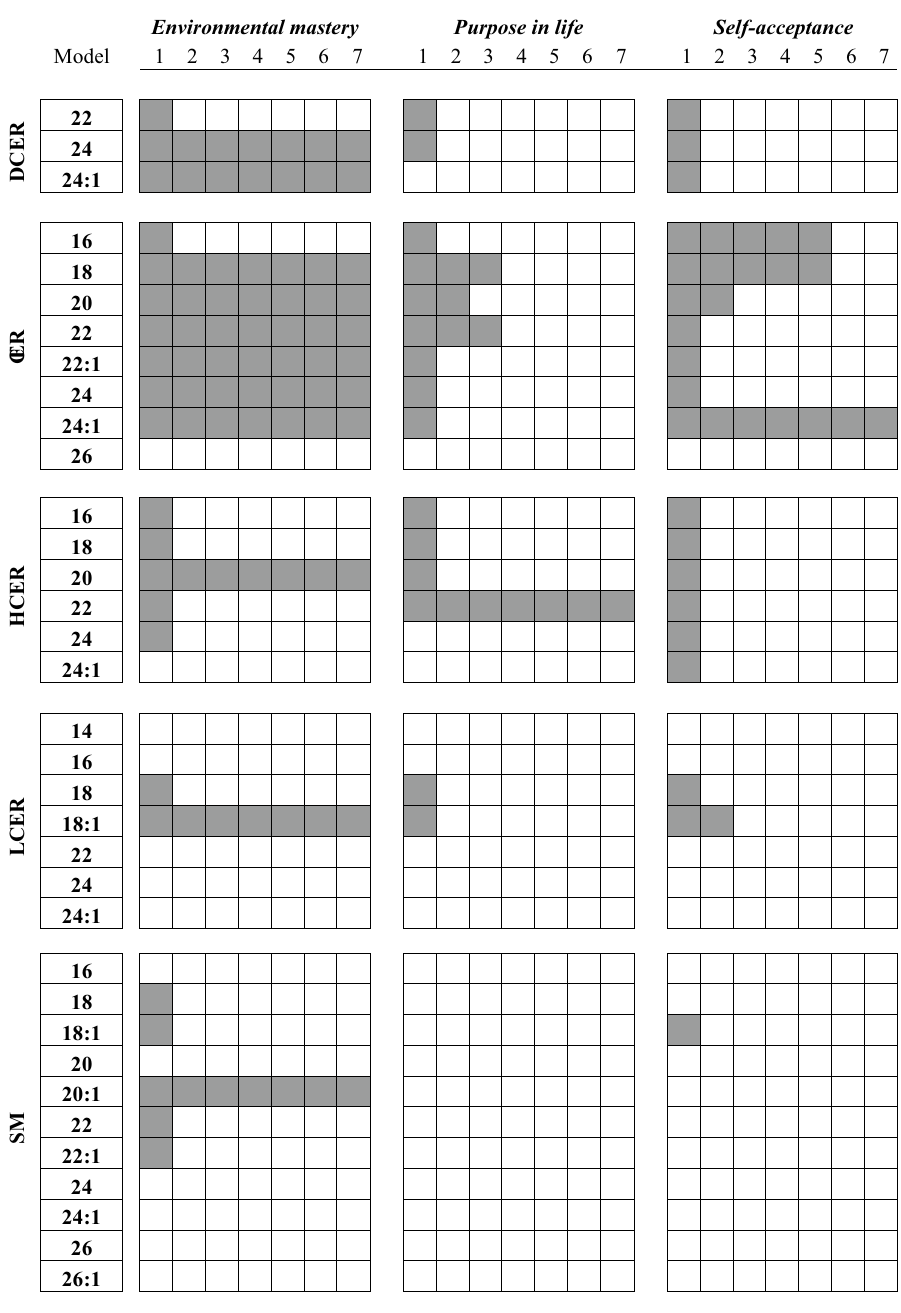
Table 5. Multivariate association analysis of the relationship between psychological well-being domains and individual species of sphingolipids. Model 1: bivariate analysis. Model 2: adjusted for demographic factors, medication usage, and depression. Models 3, 4, 5 and 6 determined the influence of each health behavior as a possible mediators, adding them sequentially: food intake quality (MIDUS-HEI) in Model 3, exercise (METs) in Model 4, sleep quality (PSQI) in Model 5, and Body Mass Index (BMI, kg/m 2 ) in Model 6. Model 7 includes adjustments for CVD and diabetes. Gray boxes represent statistically significant associations (all with p < 0.05 and regression coefficients <